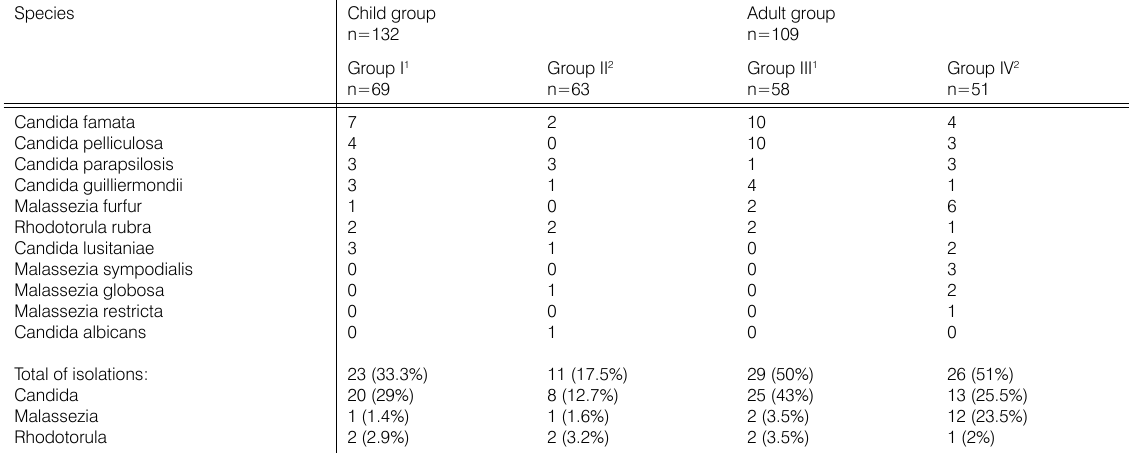
Table 1 Detection of yeast species in children and adults with atopic dermatitis (AD)